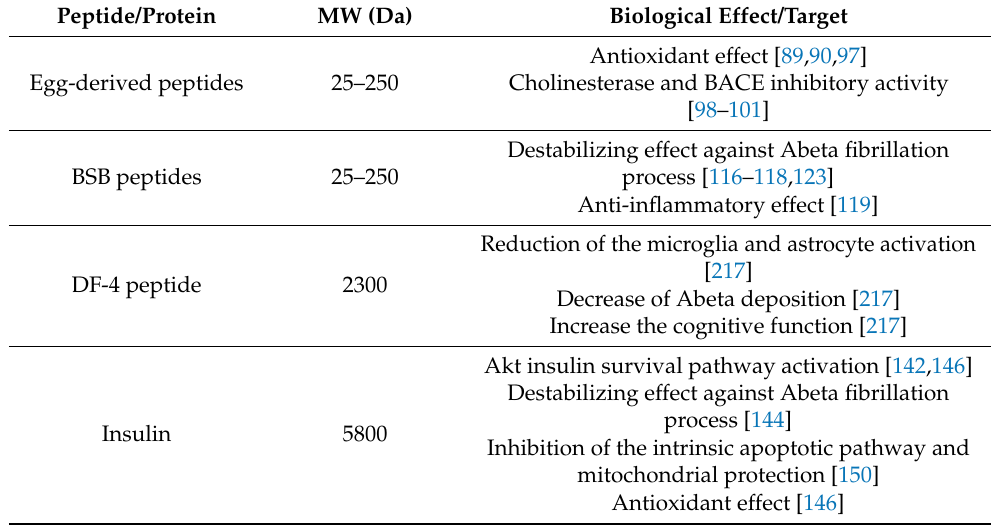
Table 1. Peptides/proteins mentioned in the manuscript, their molecular weight, biological effect or biological target, and bibliographic